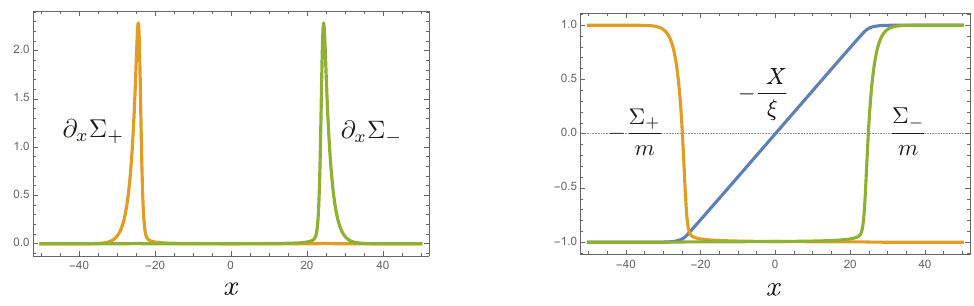
Figure 5 . The pro(cid:12)les of the kink topological charge density (left) and scalar (cid:12)elds (right) for d = 1 = 10 ; ~ d = 50. The mass and FI parameter are at the self-dual point ( m; (cid:24) ) = ( (cid:25); 1). fractional topological charge 1 =N [21]. The kinks and lumps with fractional topological charges would be related to each other in the same way as those with integer topological charges